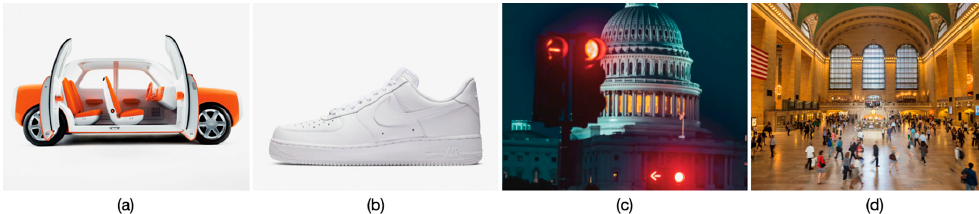
Figure 5. Examples suggested by the participants (Reprinted with permission): ( a ) Ford 021c concept car, ( b ) Nike Air Force 1, ( c ) Capitol building, and ( d ) Grand Central station.